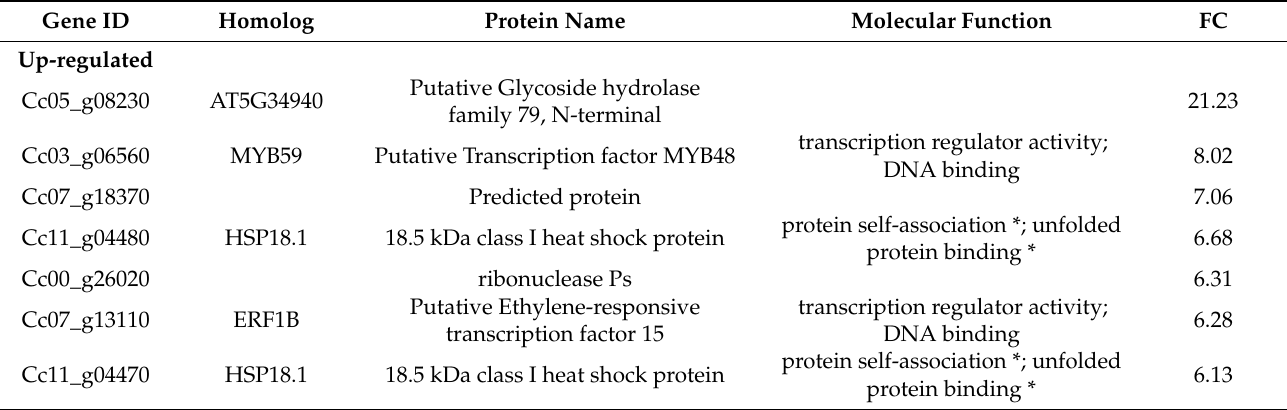
Table 3. Top 10 up and down-regulated differentially expressed genes (DEGs) under moderate water deficit (MWD) relative to well-watered (WW) Coffea arabica cv. Icatu (Icatu) plants. Molecular functions were retrieved from UniprotKB database (* functions exclusive to A. thaliana homologs). Genes are descending Fold Changes